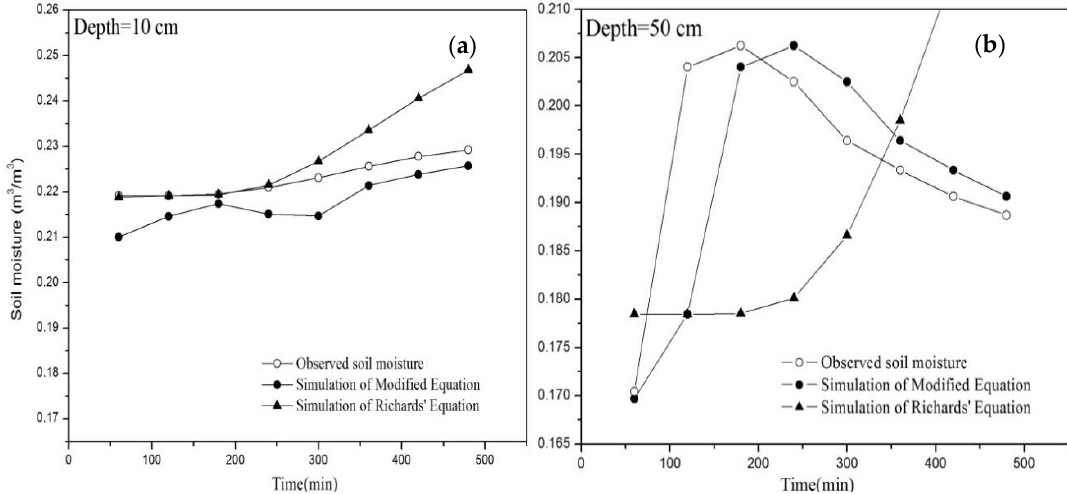
Figure 3. Comparison between observed and simulated soil moisture by the modified Richards’ equation and original Richards’ equation ( a ) at the depth of 10 cm and ( b ) at the depth of 50 cm.